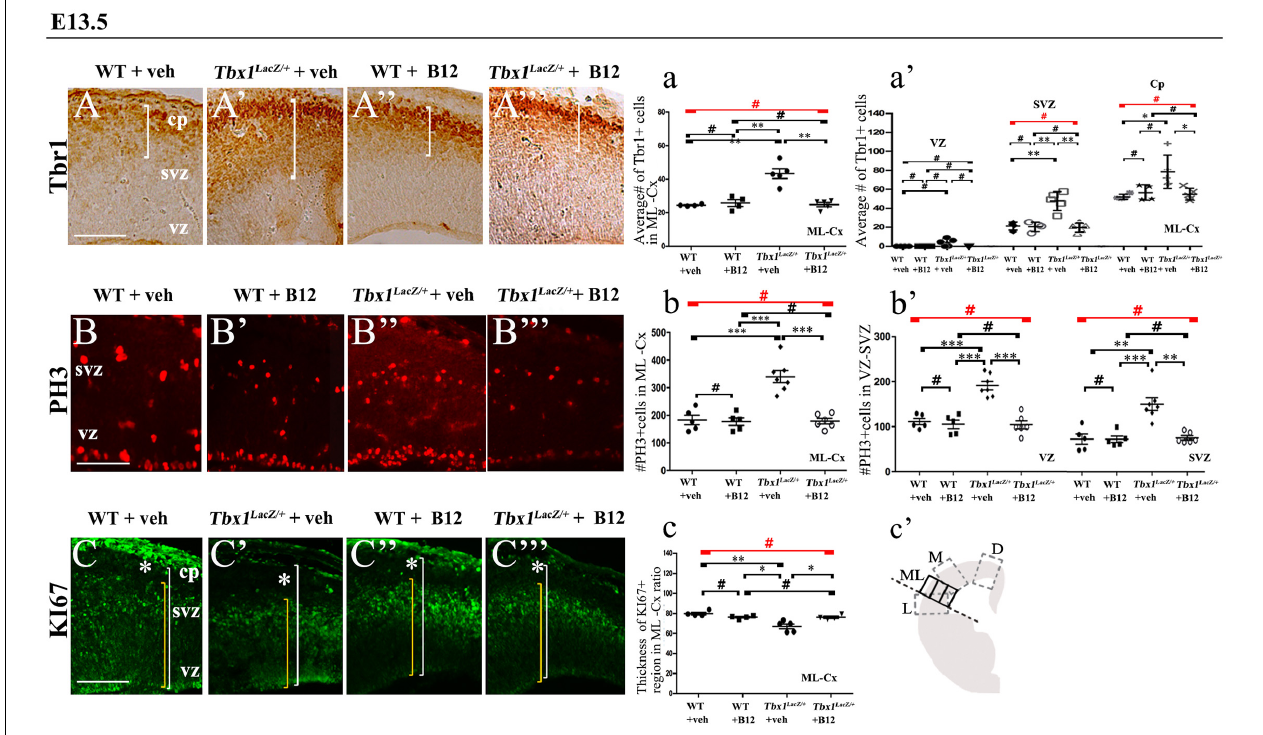
FIGURE 3 | Vitamin B12 treatment restores normal expression of cortical markers in Tbx1 heterozygous embryos. Panels show coronal sections of embryonic brains at E13.5. (A,a) Immunostaining for TBR1 (A–A”’) revealed the precocious presence of terminally differentiated neurons in the SVZ of Tbx1 lacZ / + embryos (A’) . White brackets define the regions containing TBR1-positive cells in (A,A’) . Quantitative analysis confirmed the altered distribution and frequency of mature cortical neurons in the ML-cortex, of Tbx1 lacZ / + embryos, including the SVZ and CP (a) , which was rescued by B12 treatment (A”’,a) . (B,b) Immunostaining for phospho-histone 3 (PH3) revealed increased mitotic activity in the proliferative zones (VZ, SVZ) of the ML-cortex of vehicle-treated Tbx1 lacZ / + embryos (B’,b,b’) compared to vehicle-treated WT embryos (B,b) , which was rescued by B12 treatment (B”’,b,b’) . (C,c) Immunostaining for KI67. White asterisks identify KI67-negative regions. Quantitative analysis (c) revealed the reduced thickness of the KI67- expressing region (yellow brackets) relative to the total ventricular-to-pial thickness (white brackets) in vehicle-treated Tbx1 lacZ / + embryos (C’,c) compared to vehicle-treated WT embryos (C) , which was rescued by B12 treatment (C”’,c) . The cartoon (c’) indicates the position of the ML-cortex in coronal sections, and the position of the counting boxes for cell counts. Scale bars, 100 µ m. * P ≤ 0.05, ** P ≤ 0.01, *** P ≤ 0.001, error bars indicate mean ± SD, red horizontal bars with # not significant, n = 5–6 per genotype. VZ, ventricular zone; SVZ, subventricular zone; CP, cortical plate; ML-Cx, medio-lateral cortex; D, dorsal; M, medial; ML, medio-lateral; L,